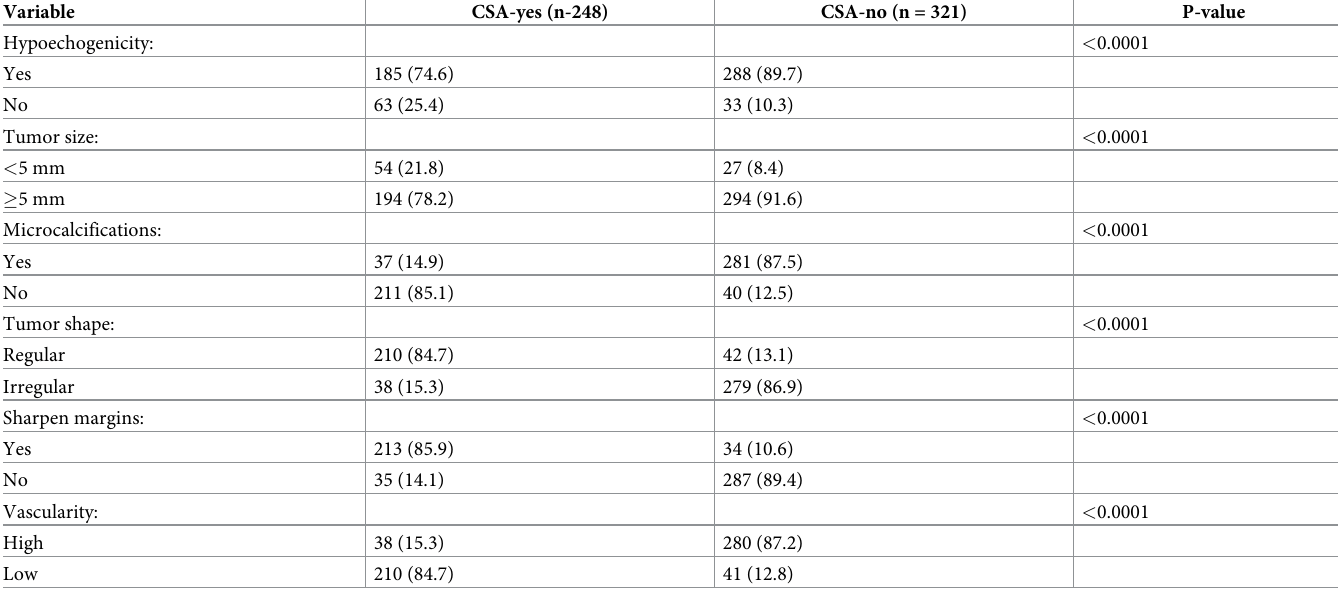
Table 3. Selected ultrasound features of thyroid cancer patients divided into two groups according cancer screening activity (CSA): CSA-yes and CSA-no. Descrip- tive data are presented as numbers (percent). Variable